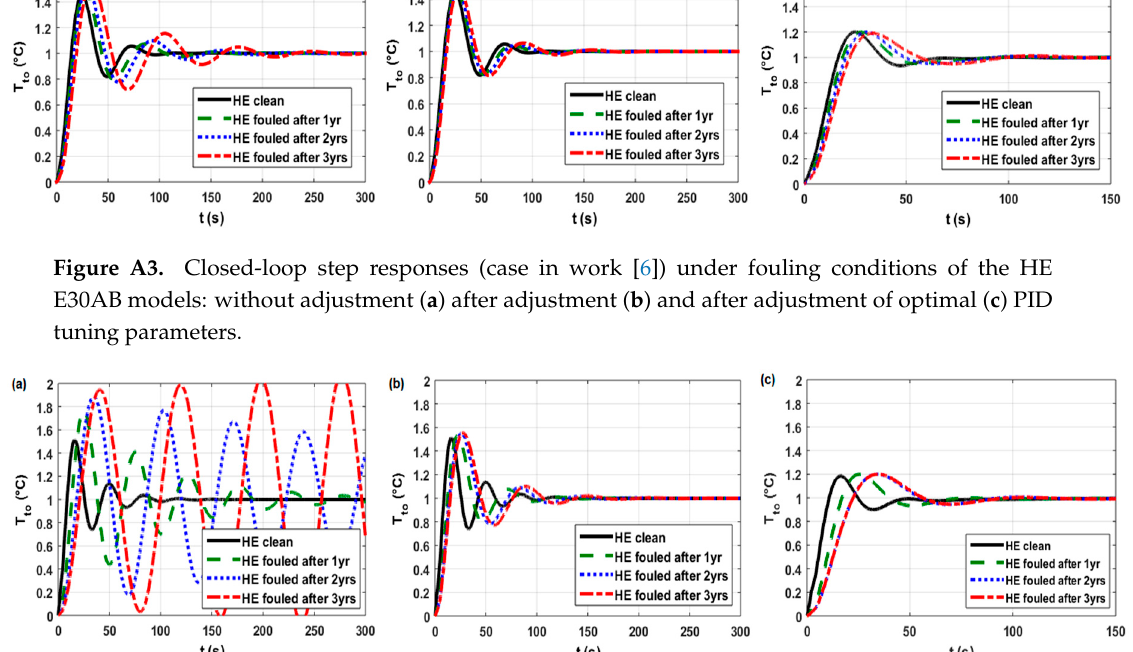
Figure A4. Closed-loop step responses (case in work [6]) under fouling conditions of the HE E35AB models: without adjustment ( a ) after adjustment ( b ) and after adjustment of optimal ( c ) PID tuning